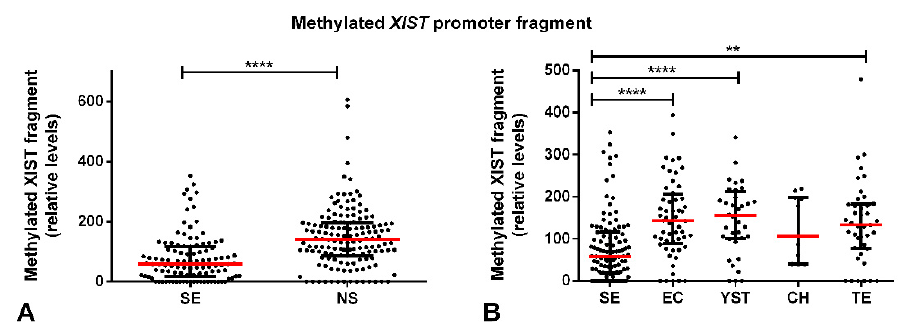
Figure 2. Methylated XIST fragment relative amounts among various tumor subtypes of the discovery cohort. Relative amounts of the methylated XIST fragment in ( A ) seminoma and non-seminoma and ( B ) all histological subtypes. **** indicates p < 0.0001 and ** indicates p < 0.01. Abbreviations: CH— choriocarcinoma;